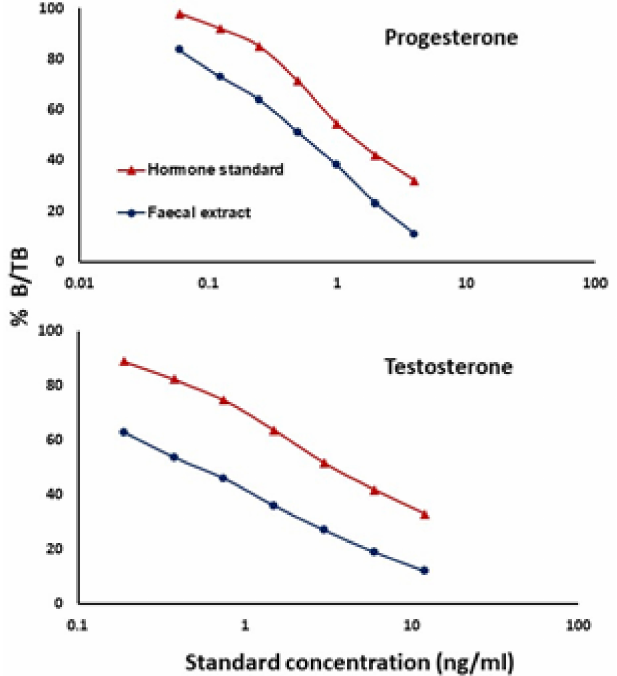
Figure 1. Parallelism between the serial dilution of pooled fecal extracts of pygmy hogs (circles) and the respective standards (triangles) of progesterone and testosterone. The Y axis show percentage binding/total binding (% B/TB) and X axis show standard concentration (ng/mL).